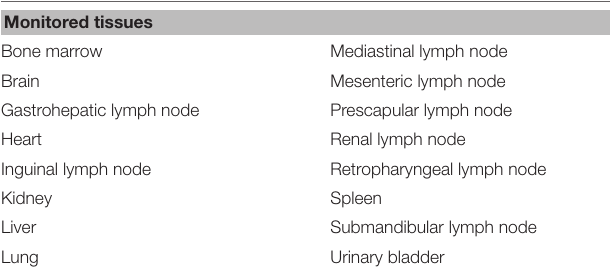
TABLE 1 | List of post-mortem tissues tested for African swine fever virus DNA using real-time PCR. Monitored